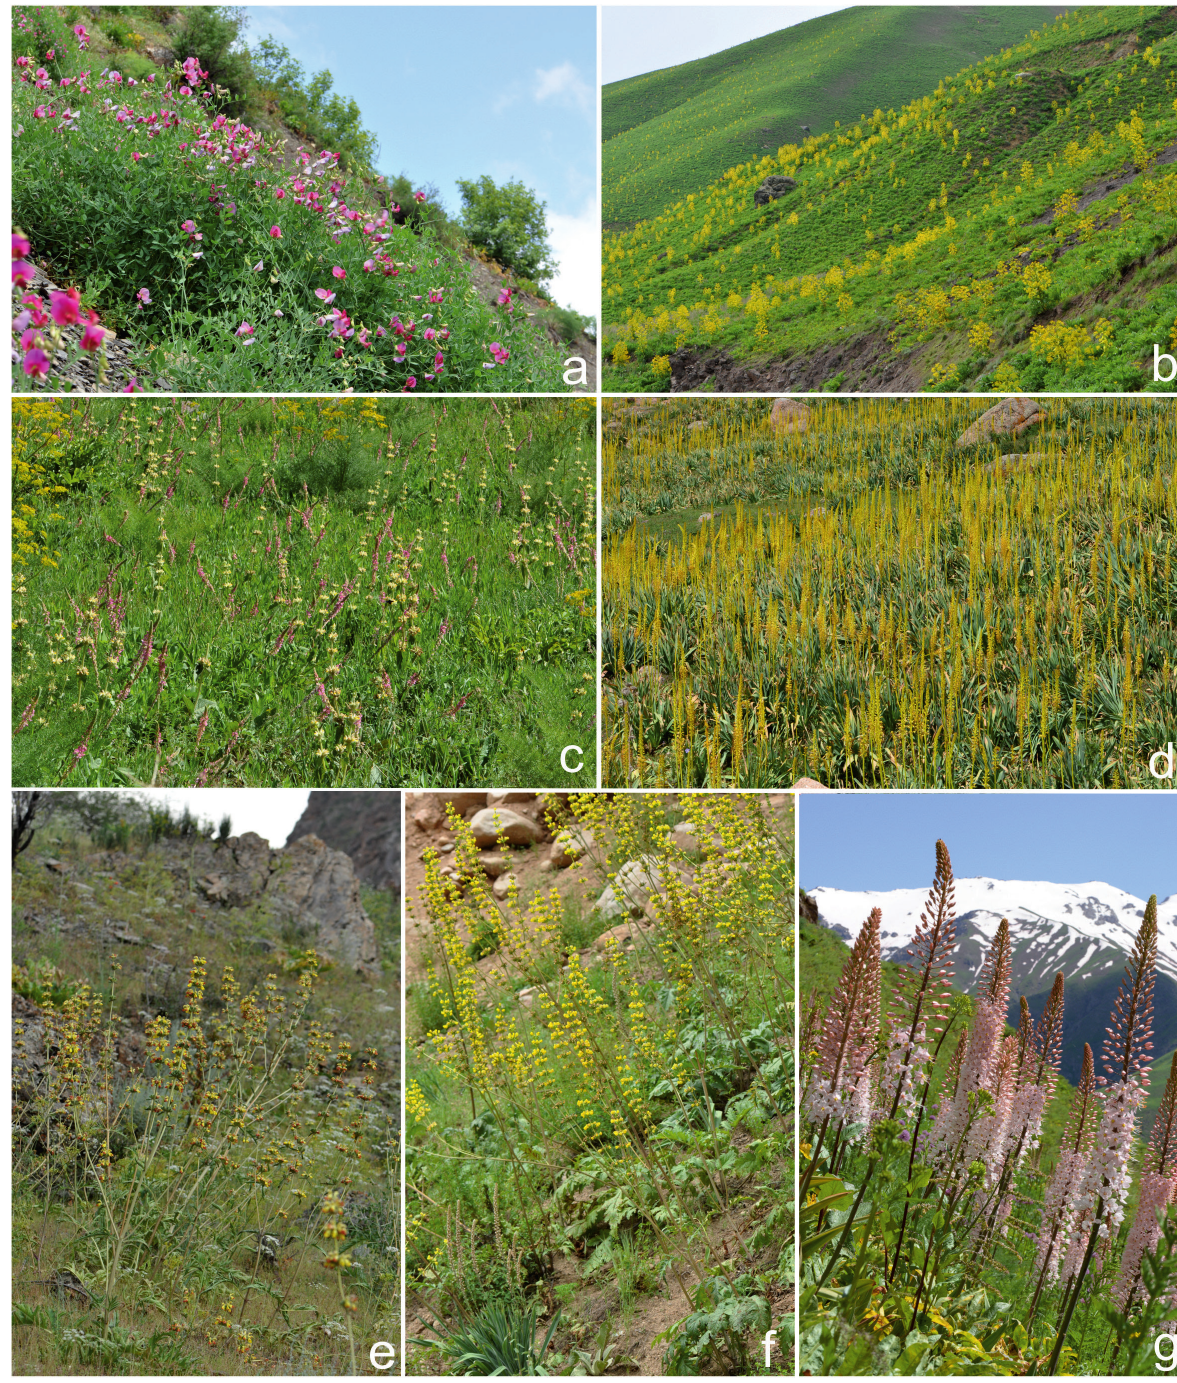
Figure 7. Photographs of the tall-forb vegetation belonging to: a – Lathyretum mulkaki near the Anzob Pass in Hissar Mountains, approx. 3,100 m a.s.l.; b – community of Ferula kuhistanica near the Hoburobot Pass in Darvaz Moun- tains, approx. 3,600 m a.s.l.; c – Phlomoido lehmannianae-Onobrychidetum grandis in the Obikhingou River Valley near Roha, approx. 3,200 m a.s.l.; d – Potentillo orientalis-Eremuretum fusci in Talas Mts, Kyrgyzstan, approx. 2,700 m a.s.l.; e – Phlomoidetum kaufmannianae near Mogien in Funn Mountains, approx. 1,600 m a.s.l.; f – Eremostachy- etum tadshikistanicae in Darvaz Mountains, approx. 1,500 m a.s.l.; g – Eremuretum robusti near Rabot, Darvaz Mountains, approx. 2,750 m